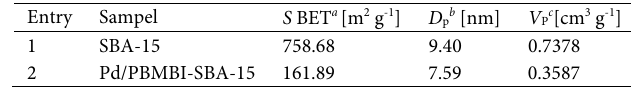
Fig. 3. N2 adsorption-desorption isotherms and pore size distributions of SBA-15, Pd@modified SBA-15 Figure 3. N2 adsorption‐desorption isotherms and pore size distributions of SBA‐15, Pd@modified SBA‐15 Table 1. Structural and Textural Parameters of SBA-15 and Pd@modified SBA-15 Table 1. Structural and Textural Parameters of SBA-15 and Pd@modified